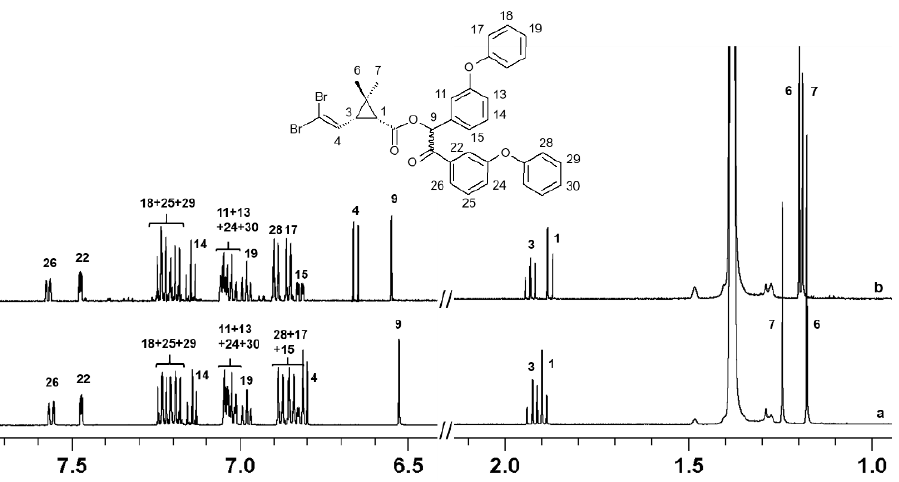
Figure 7. 1 H NMR (600 MHz, C 6 D 12 , 300 K) spectra of ( a ) R / S -PBDM and ( b ) S / R -PBDM with numbering scheme for NMR